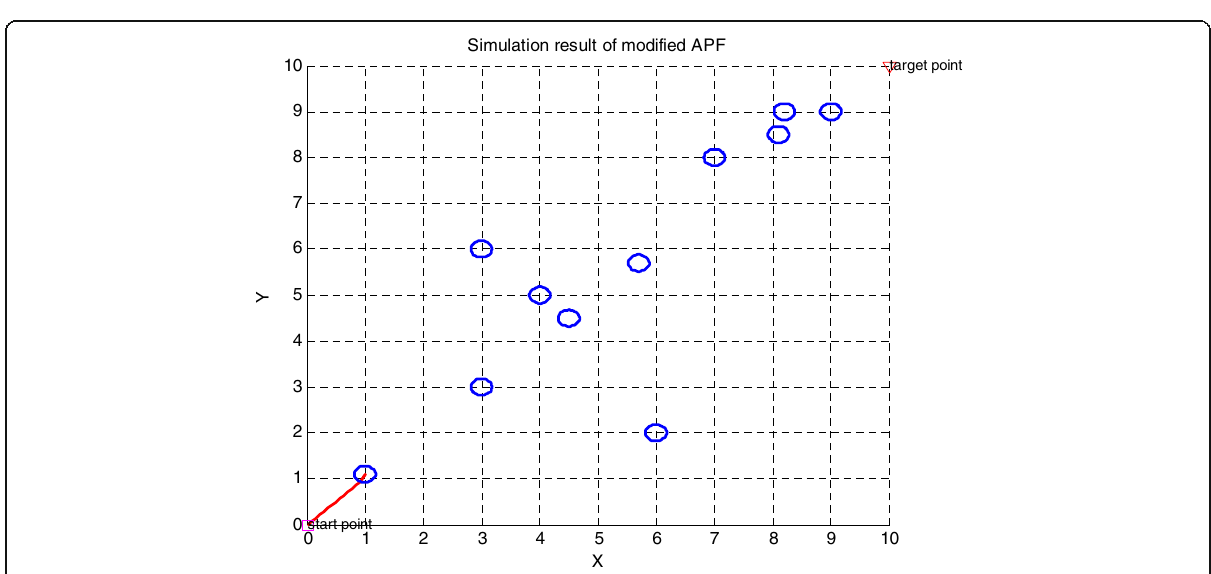
Fig. 8 The simulation result of the artificial potential field algorithm for circular obstacles with radius R =